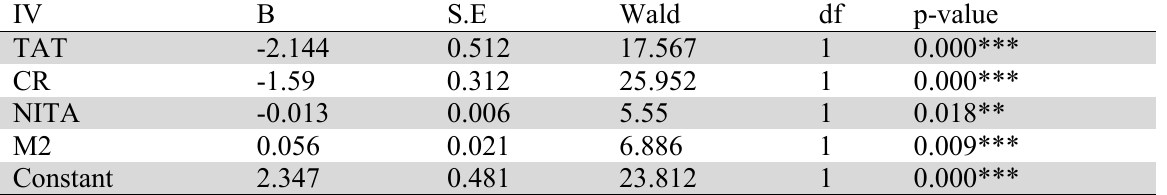
Estimation results of Logit Analysis in the manufacturing